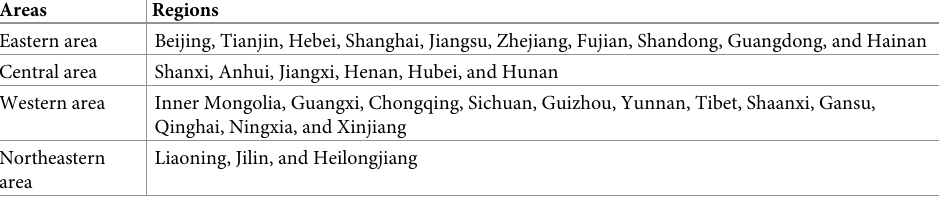
Table 6. Areas in